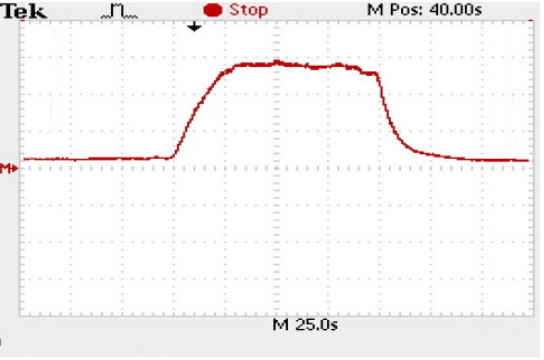
Figure 16. Measured SMESC output power: Wind speed is dropped from 8 to 5 m/s, and then raised to 8 m/s again.